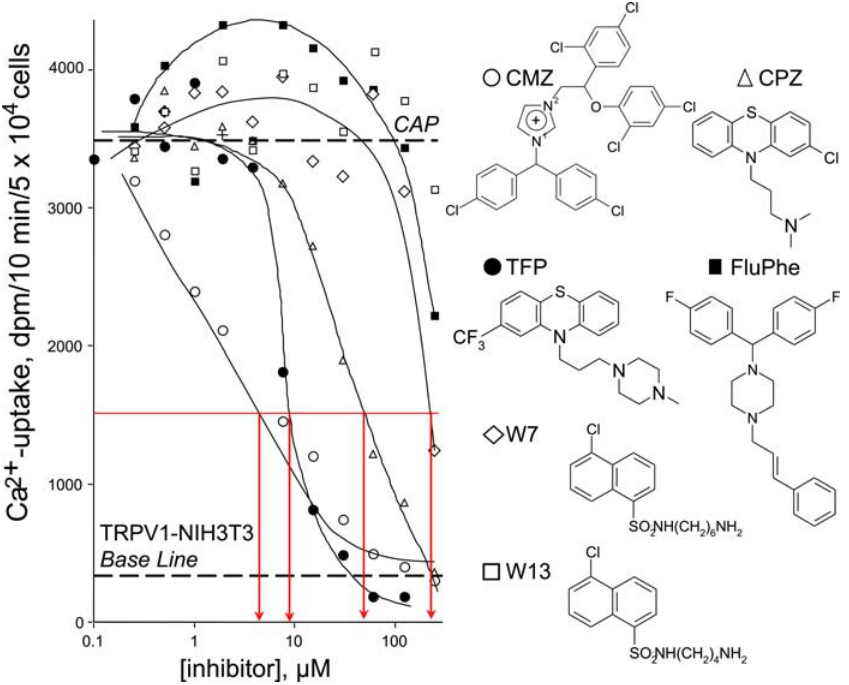
Figure 1. Antagonist activity of Ca 2 + -calmodulin inhibitors in TRPV1-NIH3T3 cells. 45 Ca 2 + -uptake experiments were carried out in 96 well plates with robotic liquid handling. Cells were co-incubated with capsaicin (capsaicin, ED 200 =2 m M) in the presence of different concentrations of Ca 2 + - calmodulin inhibitors. Calmidazolium (CMZ) . trifluoperazine (TFP) . chlorpromazine (CPZ) were identified as full antagonists of capsaicin-induced Ca 2 + -uptake, in the micromolar range, while fluphenazine (FluPhe), W7 and W13 were determined as partial or weak inhibitors. Similar efficacy order was determined in two additional experiments, carried out in duplicate samples.